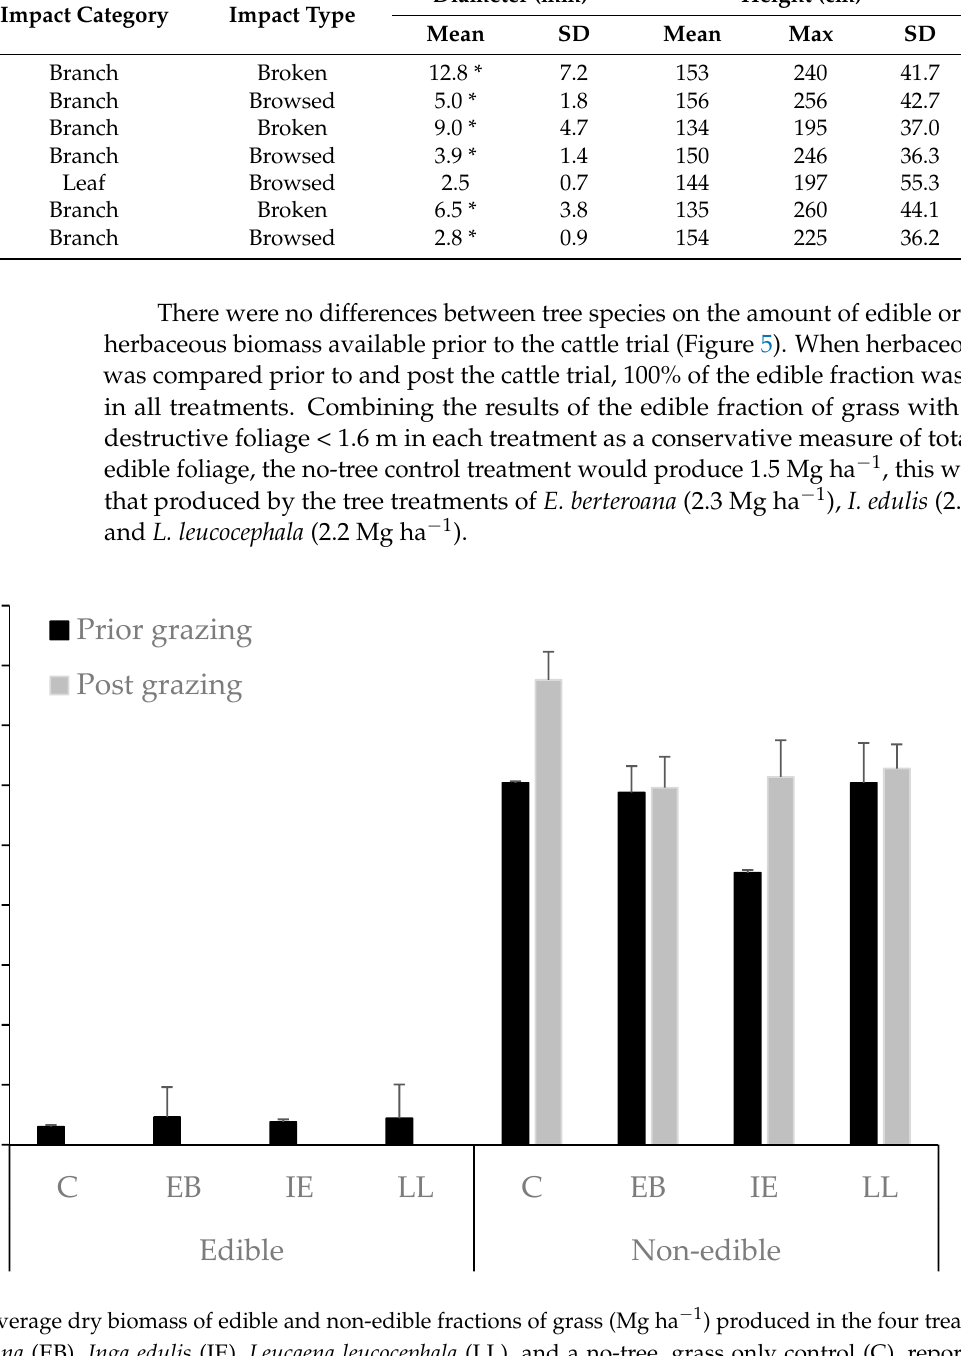
Table 4. Impacts measured following a cattle browsing trial on 30 individuals of each of three tree species E. berteroana, I. edulis and L. leucocephala . Impact types were classified as browsing-type damage (browsed) or breakage-type damage (broken) of two categories, branches (all species) and leaves ( I. edulis ). Mean diameter (mm), mean height (cm) and maximum height (cm), as well as respective standard deviations (SD) reported on a number ( n ) of individual trees. Significant differences between species ( p < 0.05) are denoted by an asterisk (*). Species